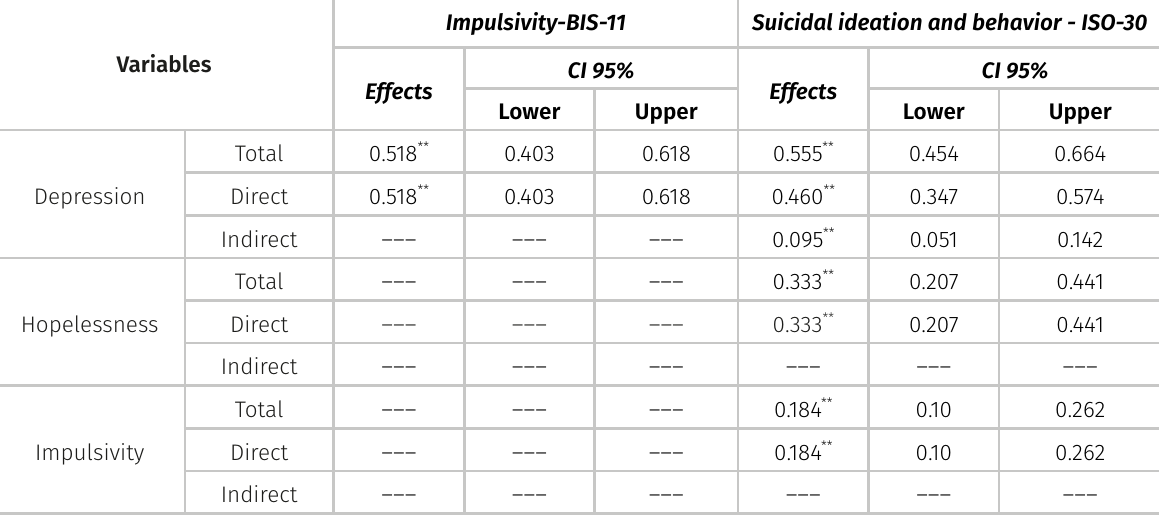
Table V. Standardized total, direct and indirect effects of predictor variables on response variables.